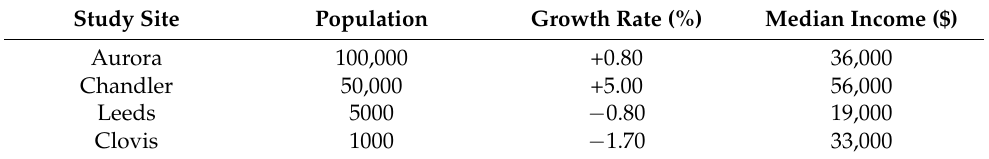
Table 1. Study site characteristics